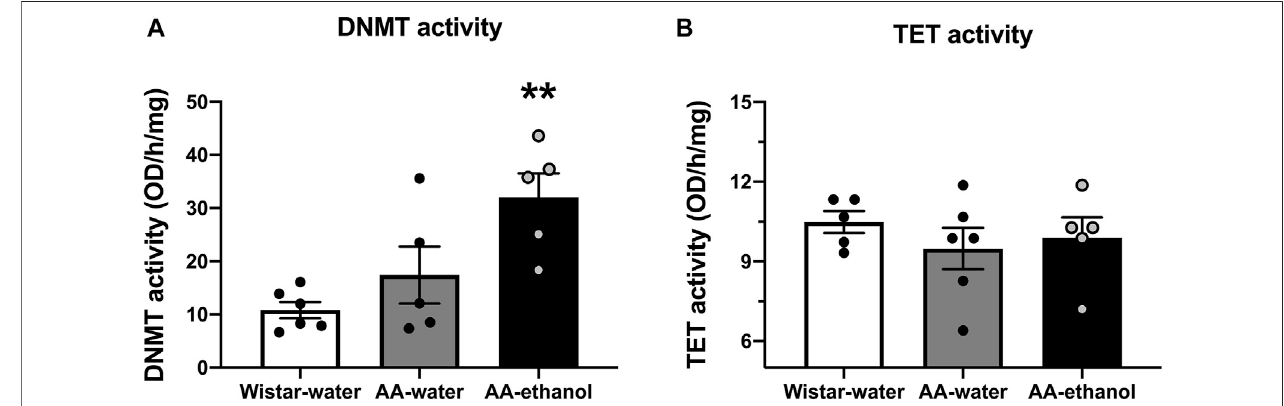
FIGURE 2 | Impact of intermittent alcohol exposure on DNMT (A) and TET (B) enzyme activity levels in the NAc. One-way ANOVA followed by Tukey ’ s multiple comparisons test; ** p < 0.01, compared with the Wistar-water group; n (cid:2) 5 – 6. Error bars indicate SEM.